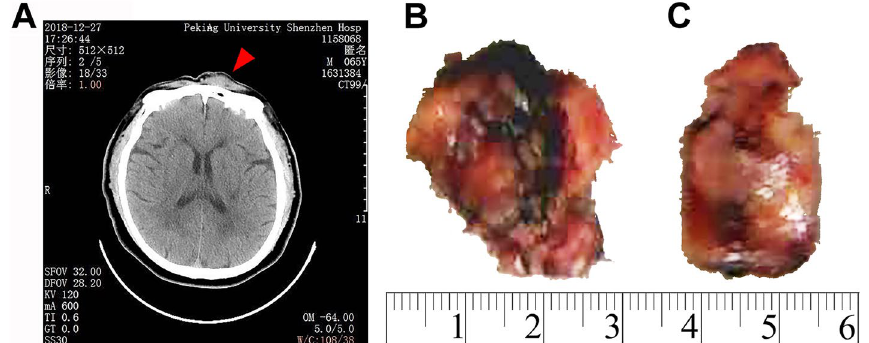
Fig. 1 A Plain CT scan of the brain showed swelling of the subcutaneous soft tissue of the forehead with increased density and CT value of 63 HU. There was no invasion of the bone. B Grossly, the tumor was gray-red and 30 mm grey-red, and slightly